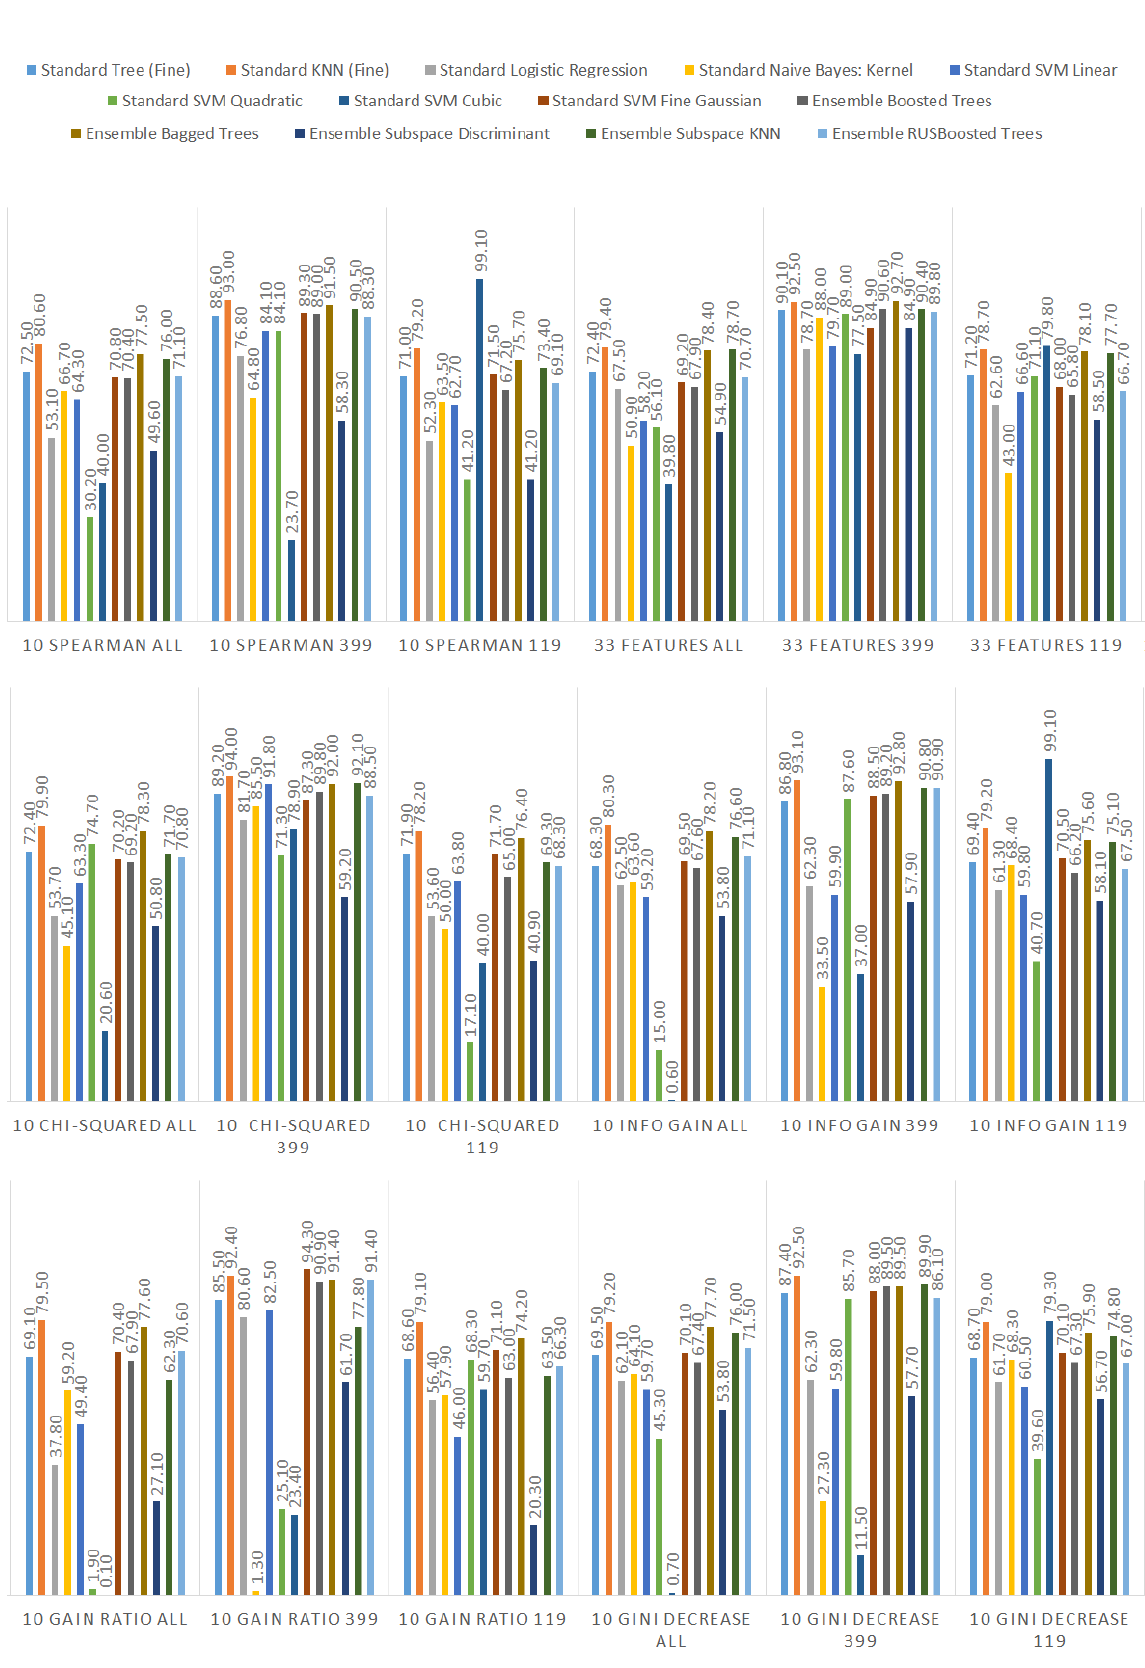
Figure 14. Detailed recall (TPR) results for different types of